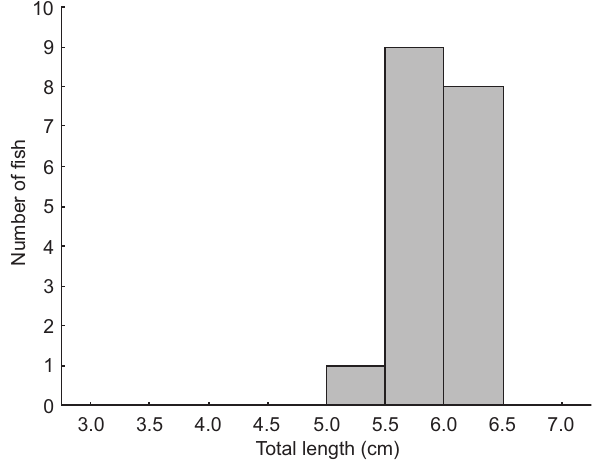
Figure 3. Number of fish per total length class tested for prolonged speed determination.